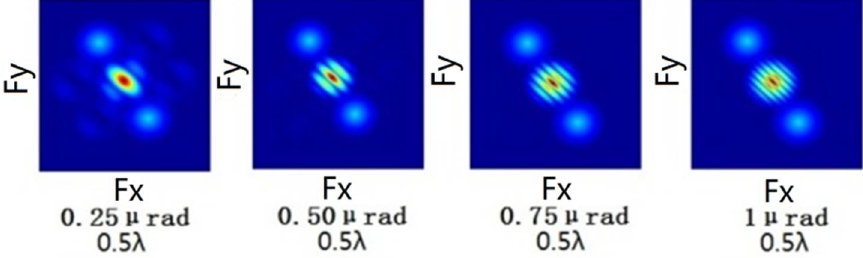
Figure 5. MTF with both piston error and tilt error.